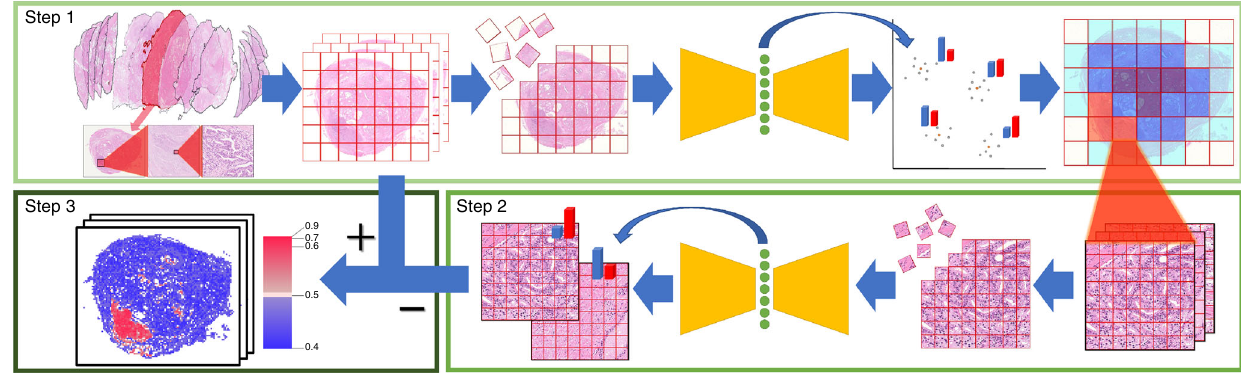
Fig. 1 Key feature generation method. This method is a type of dimensionality reduction that emphasizes not only the nucleus structure examined at high magni fi cation but also the structural pattern examined at low magni fi cation. Step 1: First, we divide low-magni fi cation pathology images into smaller images, then perform dimensionality reduction using a deep autoencoder followed by weighted non-hierarchical clustering. This process reduces an image with 10-billion-scale pixel data to only 100 feature data with scores. Step 2: Next, we analyze high-magni fi cation images in order to reduce the number of misclassi fi ed low-magni fi cation images. Again, we divide these into smaller images, before applying a second deep autoencoder and calculating average scores for the images. Step 3: Results of Step 2 complementarily correct those of Step 1. We remove images in which the results of Steps 1 and 2 do not match. Finally, we use the total numbers of each type of feature to make predictions, for example, to make cancer recurrence predictions, create human- understandable features or automatically annotate images. The color of each region indicates positive (red) and negative (blue) for characteristics